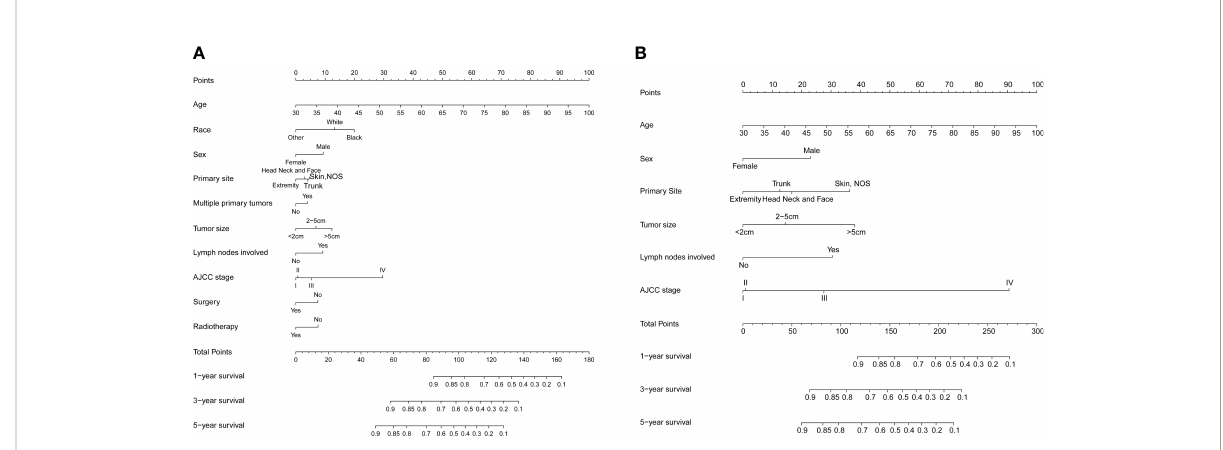
FIGURE 2 Nomograms predicting 1-, 3-, and 5-year OS (A) and CS (B) of patients with MCC.